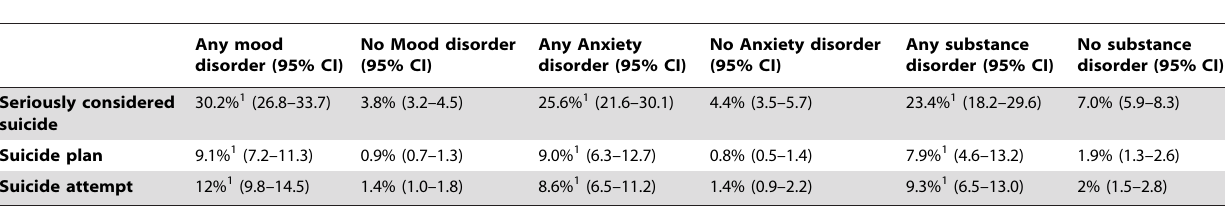
Table 2. Proportions endorsing suicidal ideation, plans and attempt among those with each category of mental